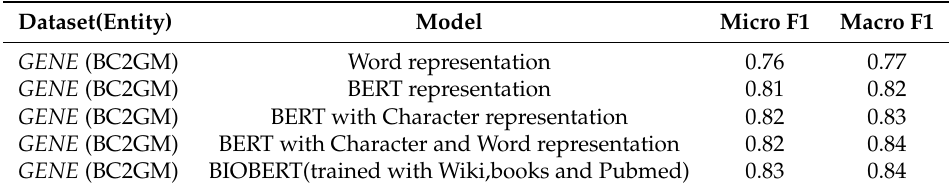
Table 9. Impact of BERT embedding : Comparison of micro- and macro-averaged F1 scores obtained on the BC2GM